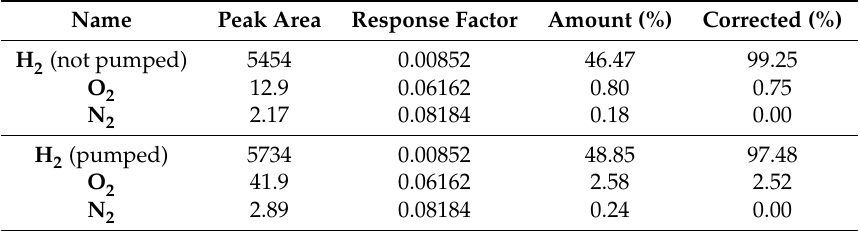
( b ) Linear Sweep Voltammetry Figure 4. ( a ) Gas chromatography (GC) measurements of gas purity of the hydrogen outlet of the electrolyser with and without pumped circulation of the electrolyte. Gas-separation membrane: 180 threads-per-inch 316-stainless steel woven mesh; electrolyser current: 5A; electrolyte: 3 M NaOH. ( b ) Linear sweep potentiometry (LSP) between 0A and 2.5A to check for evidence of bipolar-electrode behaviour. No such behaviour is observed. Table 2. Gas purity calculations based on the data presented in Figure